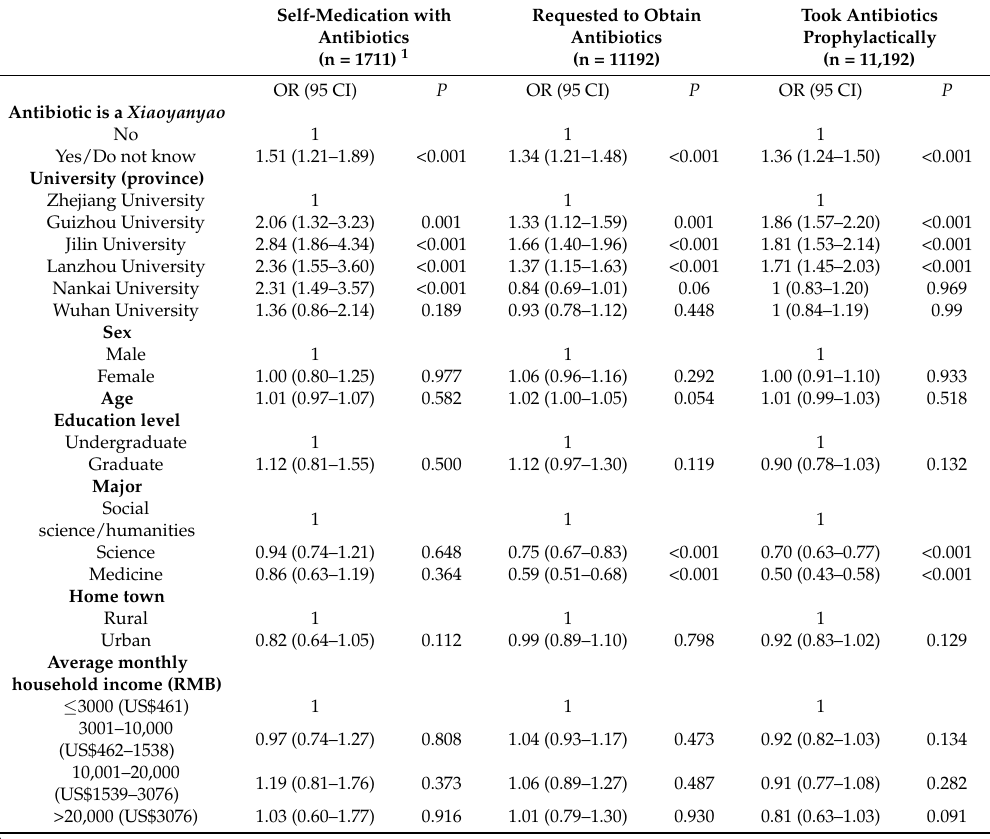
Table 3. Logistic regression of the misconception and antibiotic misuse